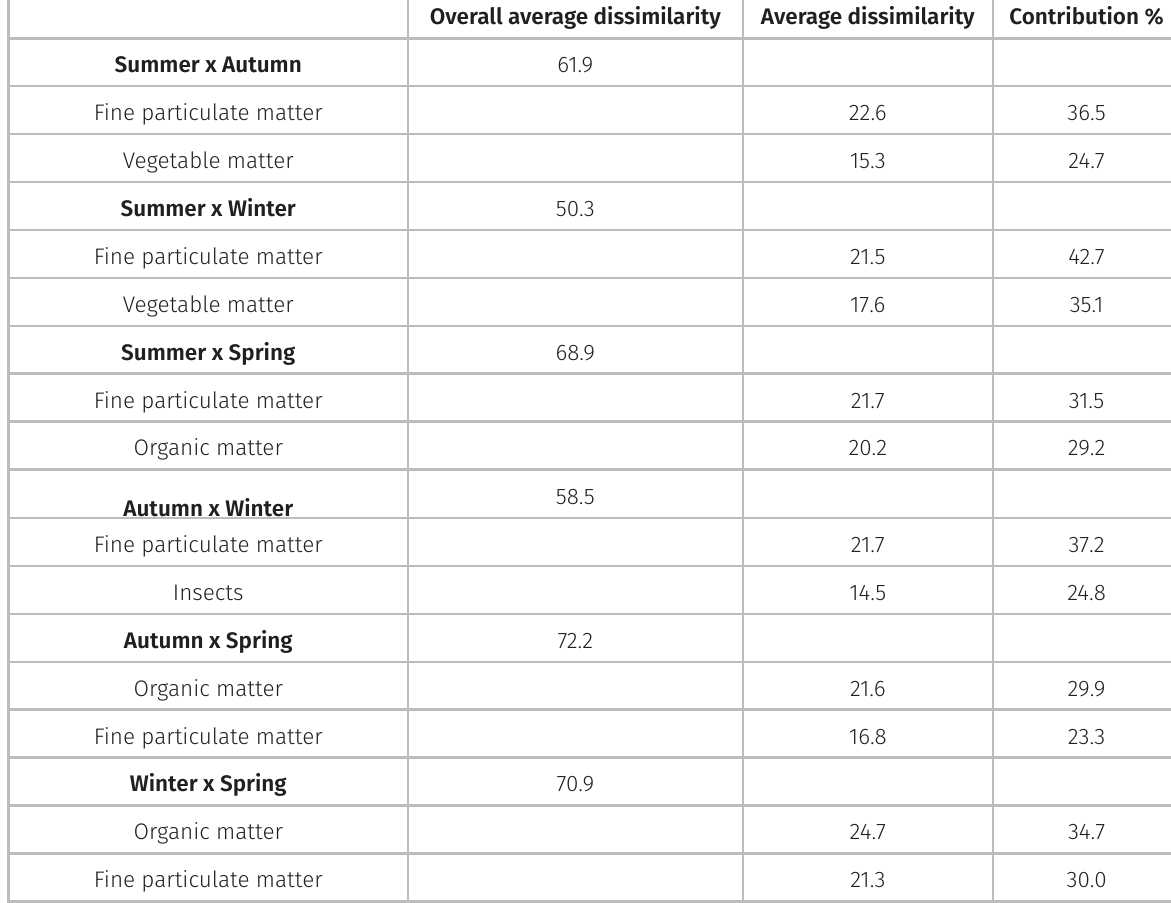
Table IV. Similarity percentages (SIMPER) using for avalue the dissimilarity among the seasons of the year in the feeding of L. anus in the Chasqueiro reservoir, southern